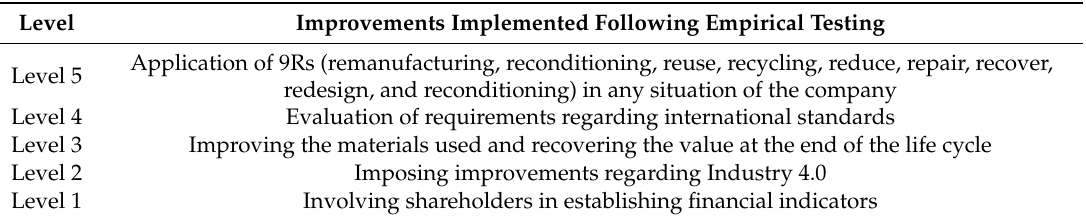
Table 8. The results obtained during the